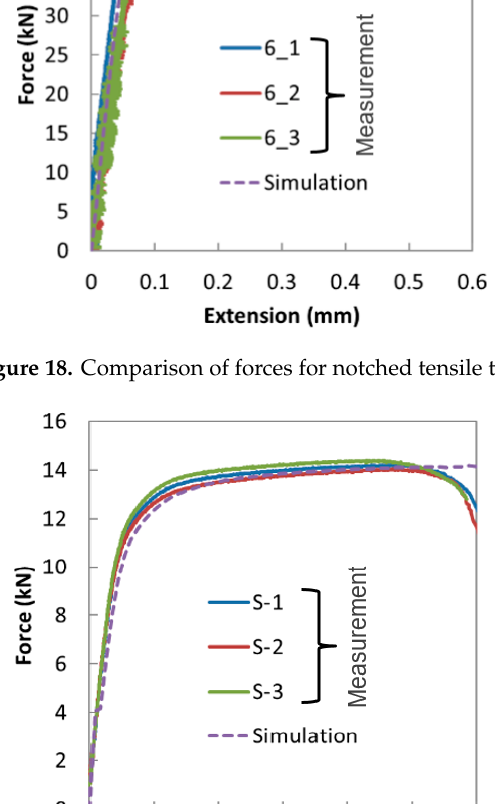
Figure 21. The fracture location in 2D simulation of notched tensile test. Figure 22. The fracture point in simulation of the shear test.